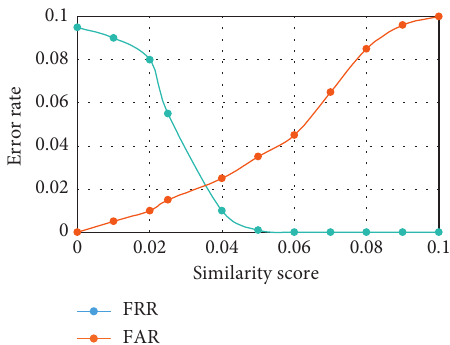
Figure 8: Equal error rate for DIARETDB1.